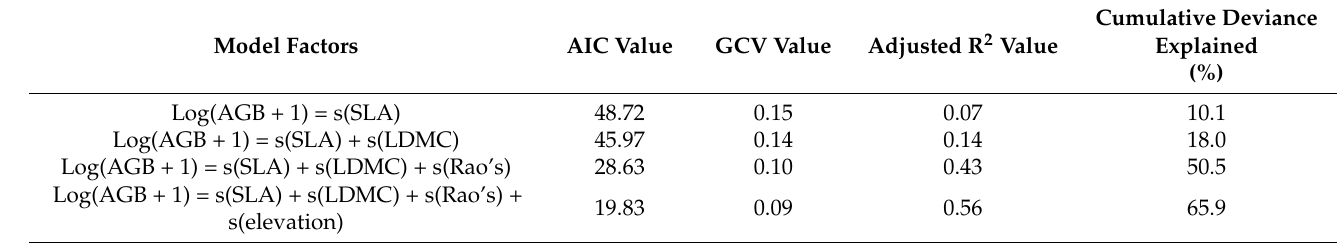
Table 2. Deviance analysis for the general additive models (GAMs) fitted to the